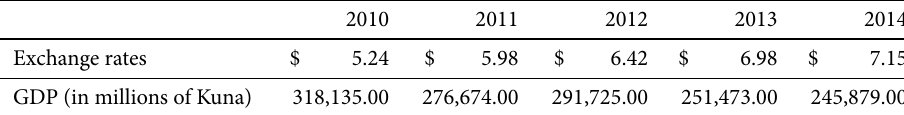
table 4. kuna exchange rate depreciation scenario impact on GDp